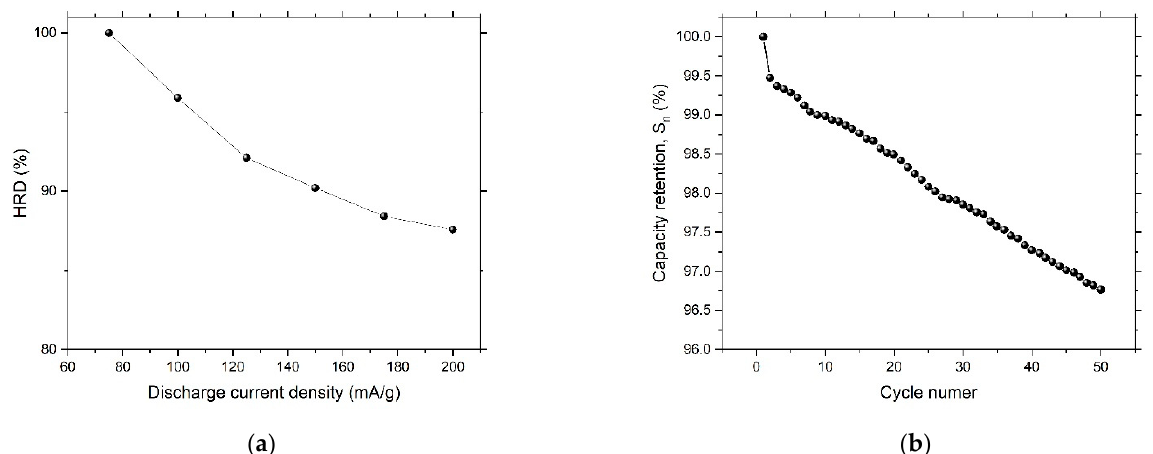
Figure 13. ( a ) High-rate dischargeability (HRD) and ( b ) capacity retention ( S n ) for the dealloyed glassy alloy ribbon sample.